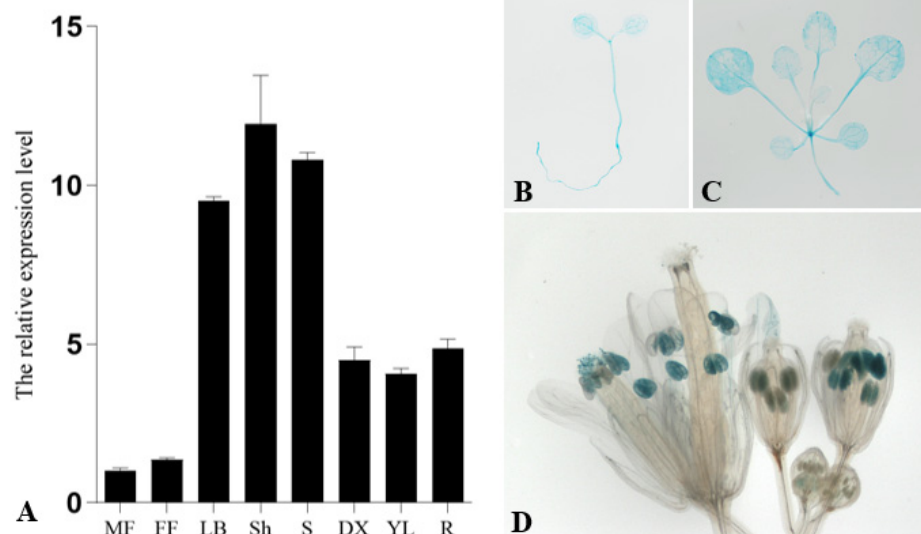
Figure 1. Spatiotemporal expression patterns of PsnCYCD1;1 gene. ( A ) The relative expression level of PsnCYCD1;1 gene in different tissues of P. simonii × P. nigra . MF: male flowers; FF: female flowers; LB: leaf buds; Sh: shoots; S: stems; DX: differentiating xylems; YL: young leaves; R: roots. Histochemical analysis of the GUS activity during different developmental stages of the ProPsnCYCD1;1 ::GUS transgenic Arabidopsis . GUS staining was observed in the 7-day old seedlings ( B ), three-weeks old seedlings ( C ), and the mature anthers in flowers ( D ).